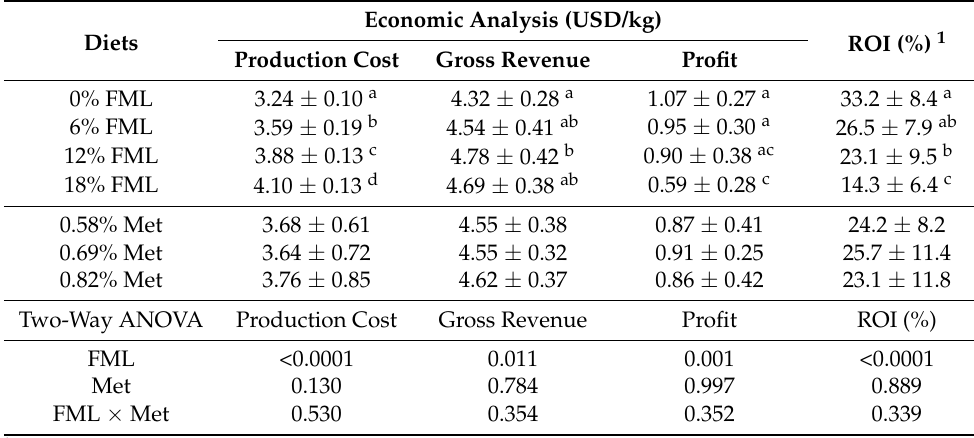
Table 8. Economic analysis of experimental diets as a function of fish meal (FML) and dietary methionine (Met) content. Common letters indicate non-statistically significant differences between dietary FML inclusion levels according to Tukey’s HSD test ( p <